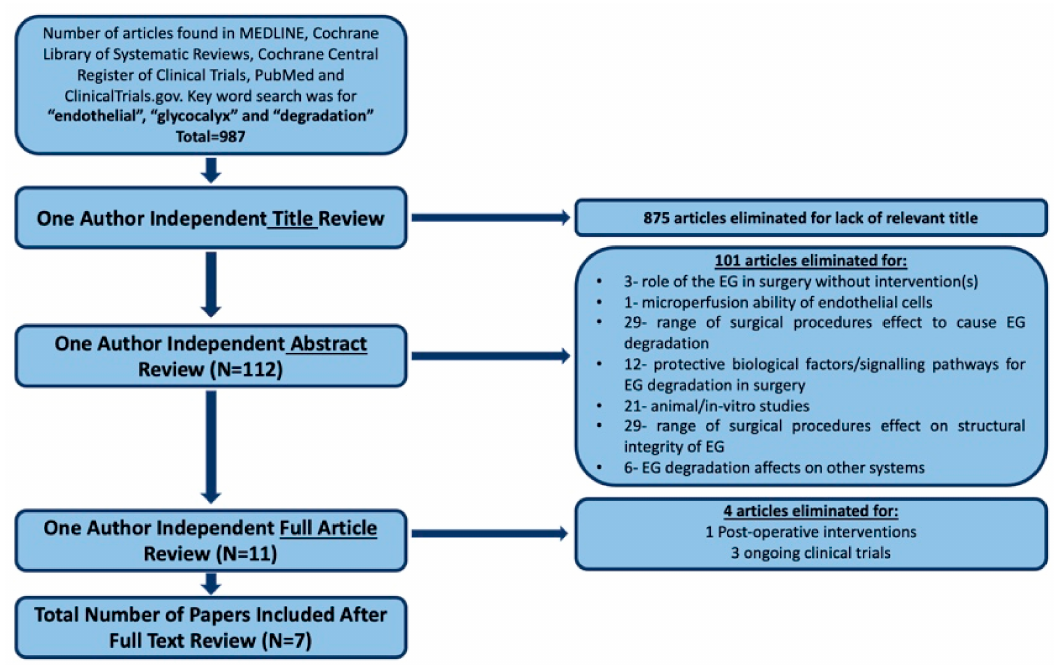
Figure 2. PRISMA flow chart of search strategy to identify pivotal publications of protective treatments against EG degradation in surgery for